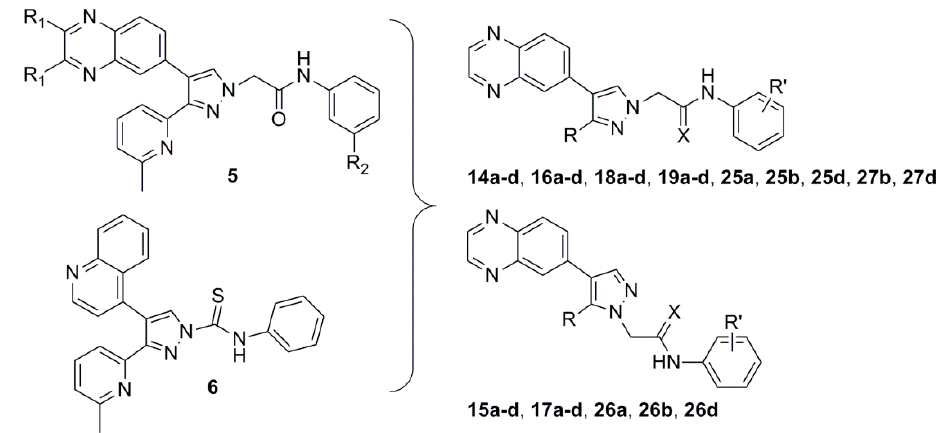
Figure 2. Design strategy based on compound 5 and 6.